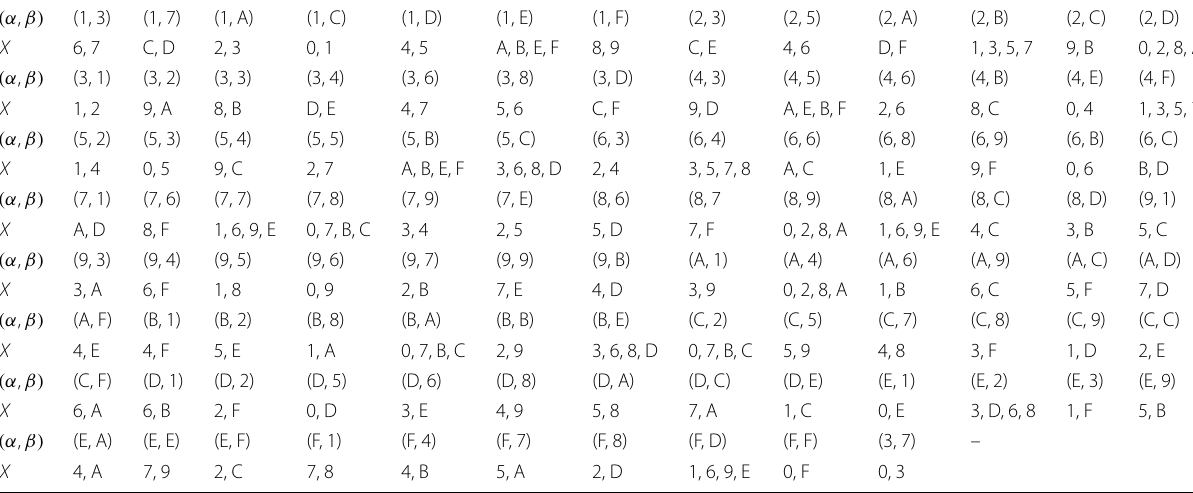
Table 4 The correspondences of input–output differentials for S-Box of